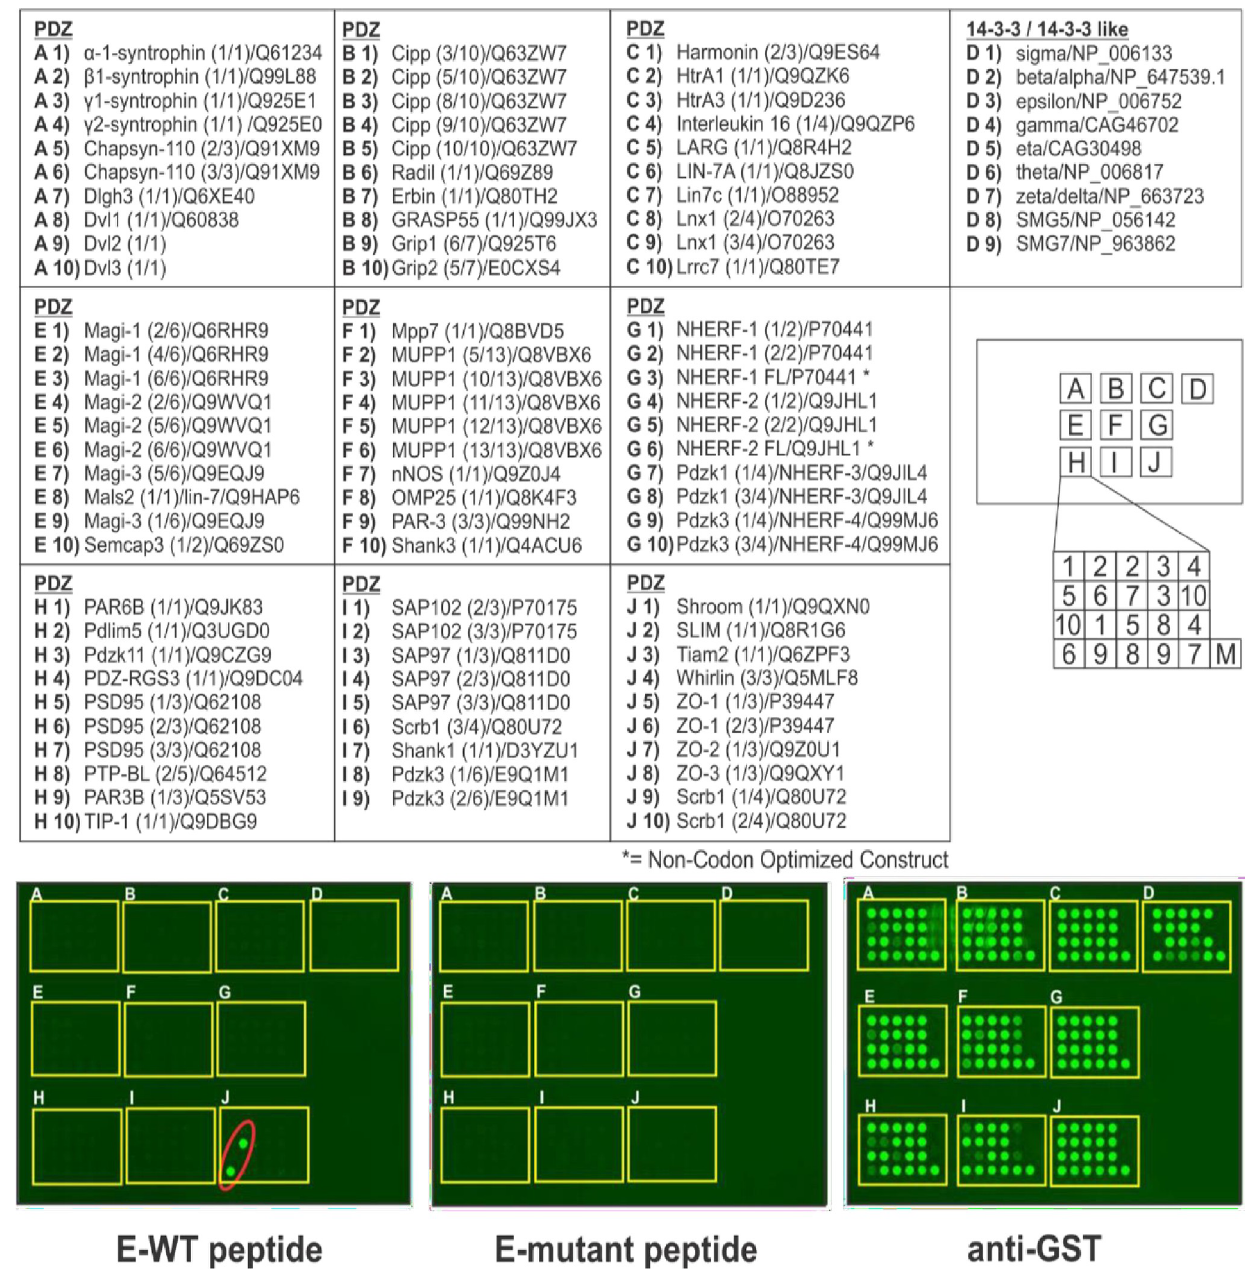
Fig 2. Screening array of GST-PDZ domain fusion proteins. The indicated GST-PDZ and GST-14-3-3 domain fusion proteins per lettered box were arrayed in duplicate as shown. The bottom right sample (M) in each box represents GST alone as a negative control. The array was screened with biotinylated E-WT or E-mutant peptides of SARS-CoV-2 E protein. Representative data for E-WT peptide (Biotin-SRVKNLNSSRVPDLLV) (100 μ g), and E-mutant peptide (Biotin-SRVKNLNSSRVPAAAA) (100 μ g) are shown (bottom panels). The E-mutant peptide did not interact with any GST-PDZ or GST-14-3-3 domain fusion proteins, whereas the E-WT peptide interacted strongly and solely with GST-PDZ domain #2 from human ZO1 in position 6 in box J (red oval). A positive control for expression of all GST fusion proteins is shown (anti-GST).